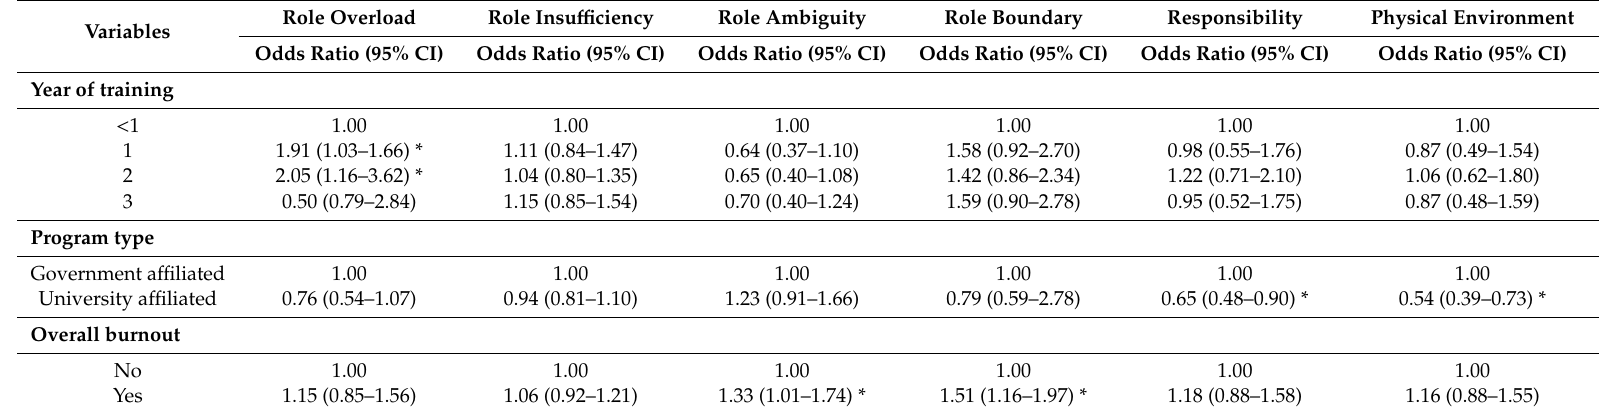
Table 3. Ordinary logistic regression of variables associated with occupational stress in each